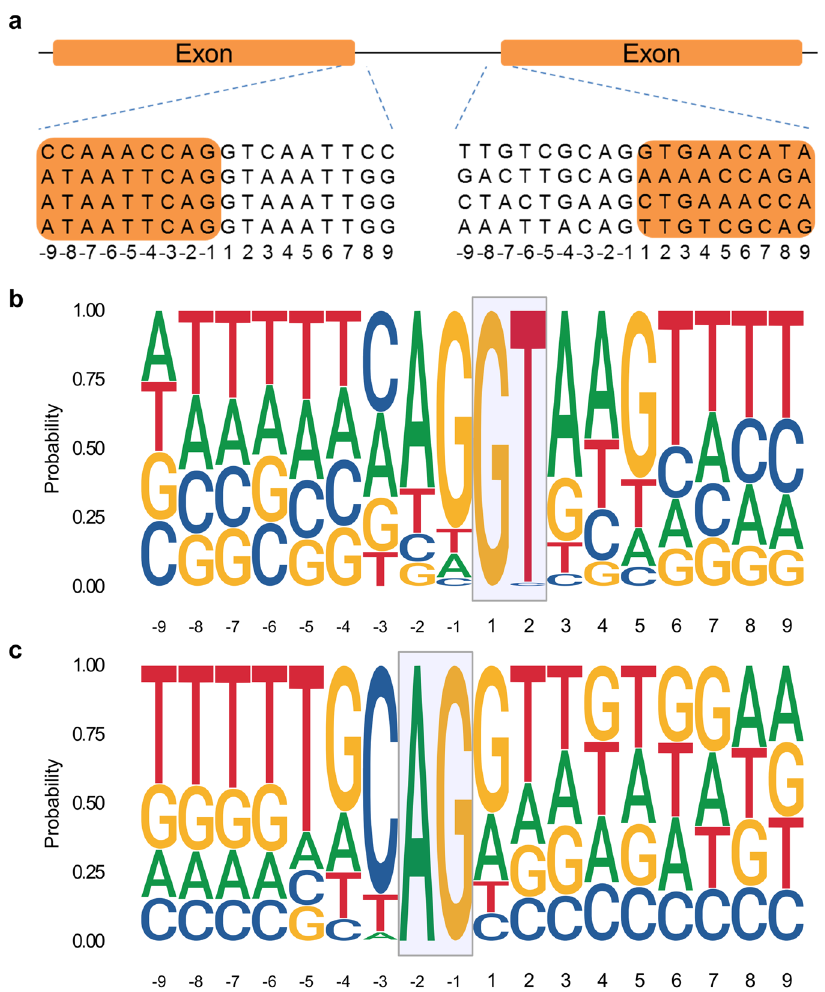
Fig. 3 Schematic representation of donor and acceptor sites within the FIX sequence and consensus sequence motifs of donor and acceptor splice sites recovered from all 87,533 P. patens transcripts. a Donor and acceptor sites. Four different splicing motifs were identi fi ed after sequencing FIX variants. Left side shows donor site and right side shows acceptor site. “ -1 ” represents last nucleotide of exon in the donor site (left side) or last nucleotide of intron in the acceptor site (right side). Consensus genomic sequence motifs of donor ( b ) and acceptor splice sites ( c ) extracted from all 32,926 P. patens protein- coding genes. The probability and height of individual letters correspond to base frequencies at each